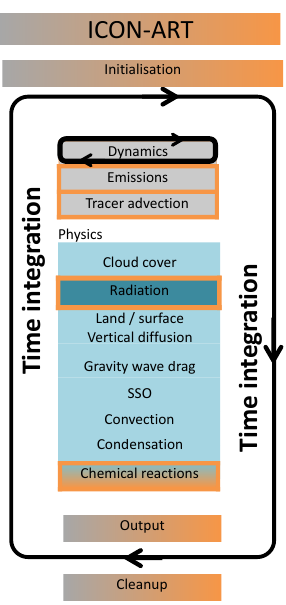
Figure 2. Schematic describing the process calling structure in the climate configuration of ICON-ART